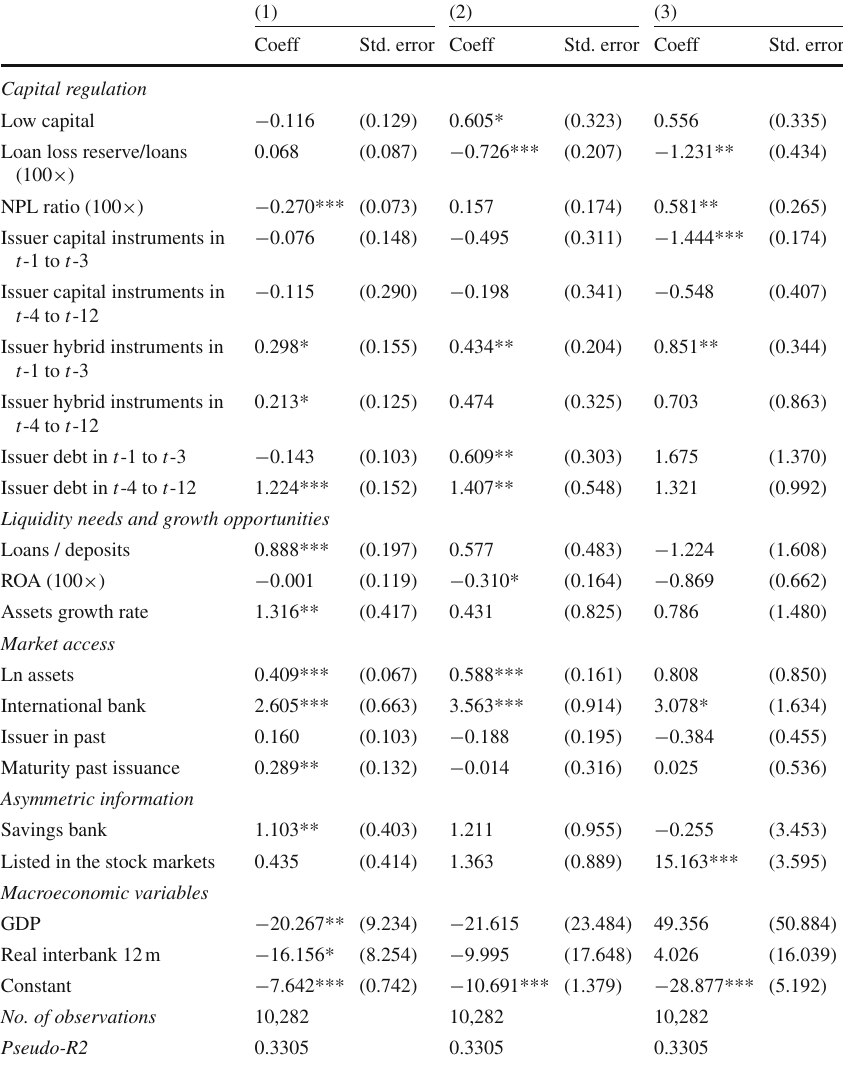
Table 3 Multinomial logit estimation of the decision to issue (or not to issue) among debt, hybrid instru- ments, or capital